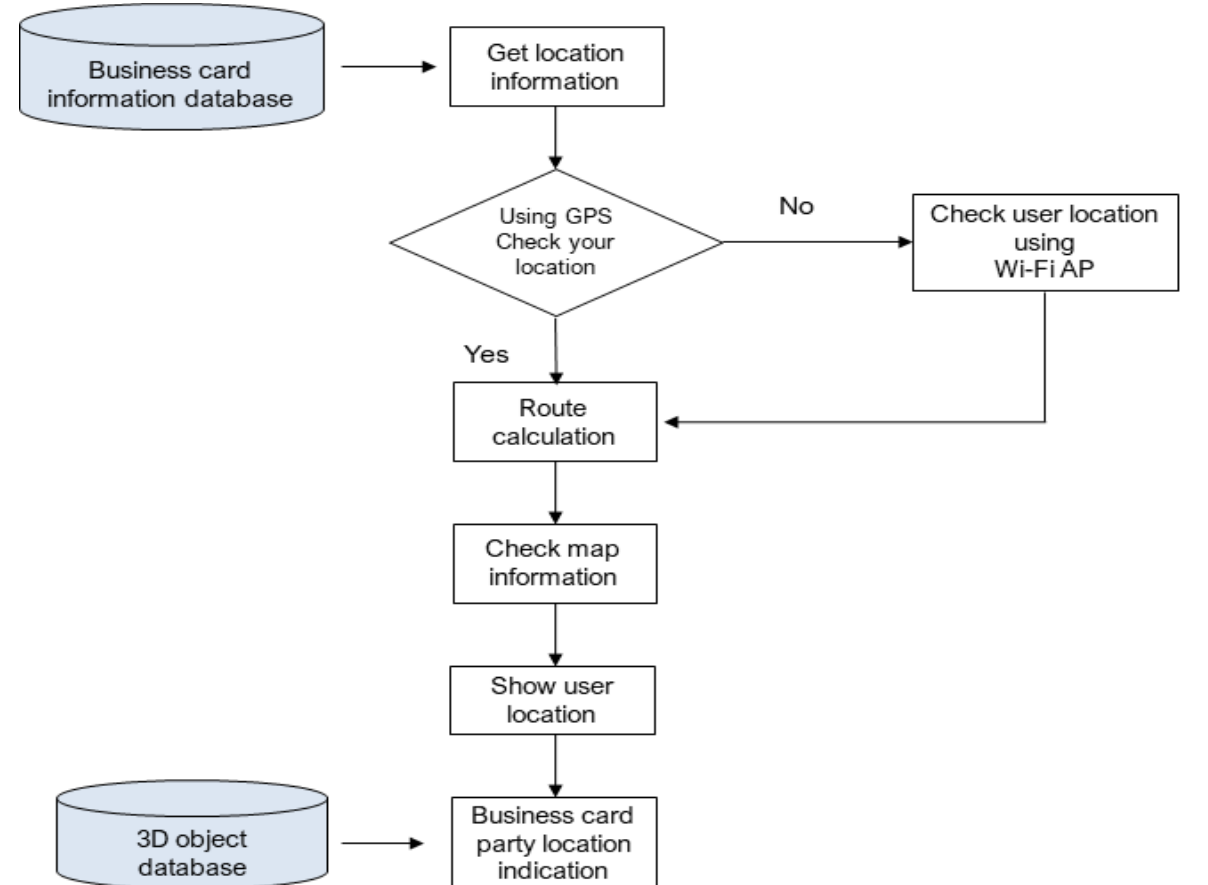
Figure 6. Location information provision service flow chart.